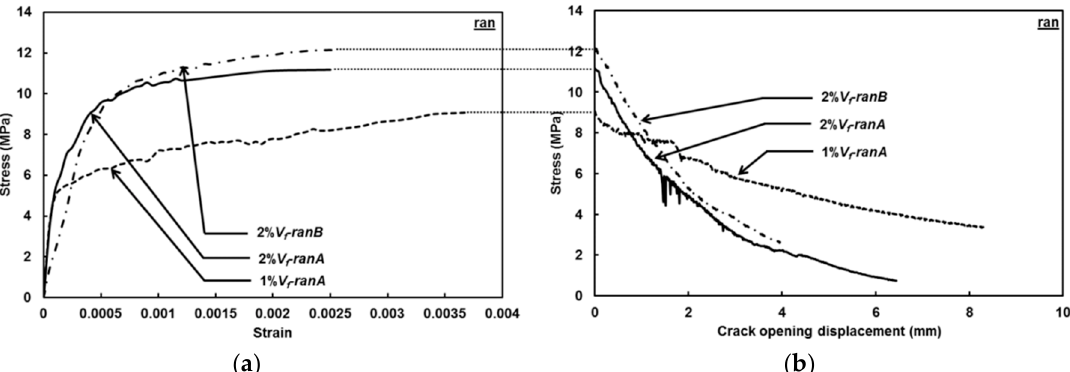
Figure 9. Average curves for UHPC with random fiber orientation under uniaxial tension: ( a ) Stress versus strain; ( b ) Stress versus crack opening displacement.